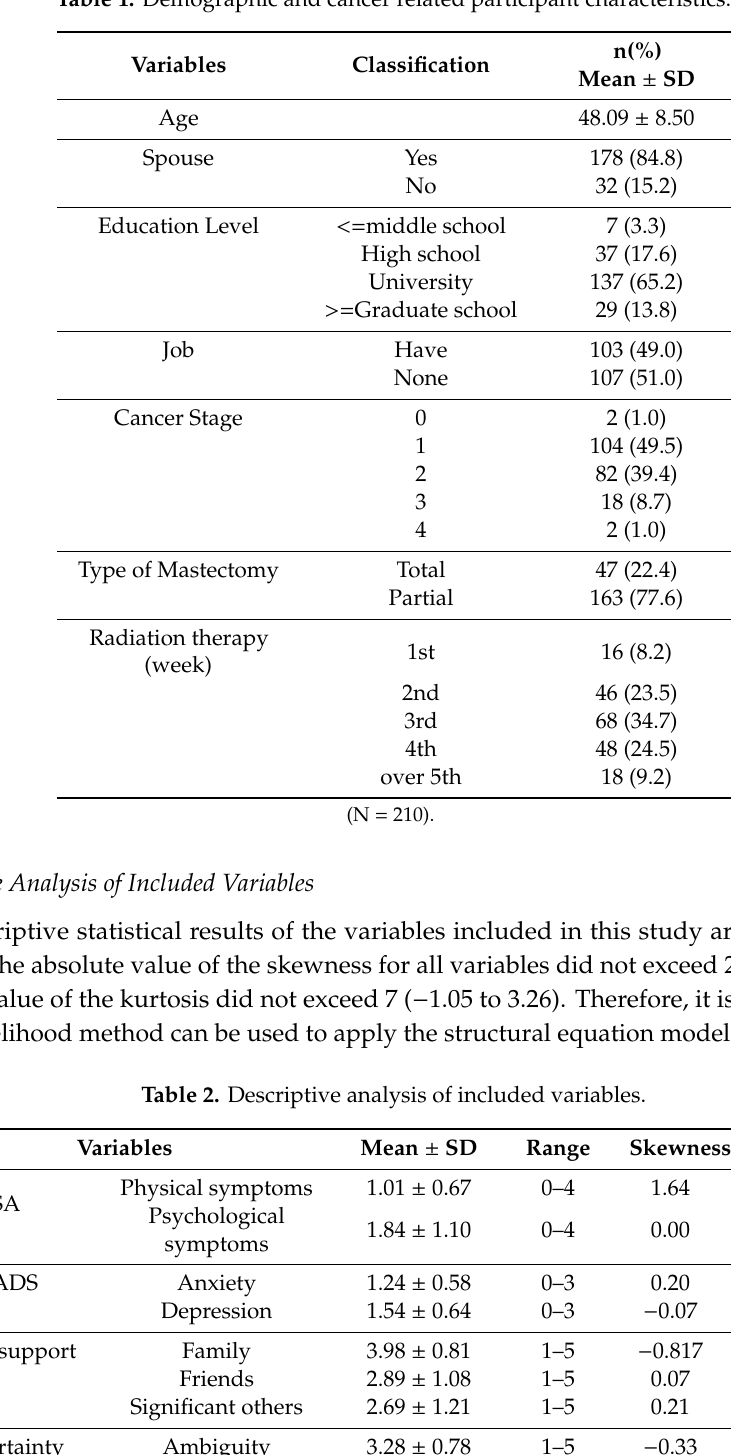
Table 1. Demographic and cancer related participant characteristics.